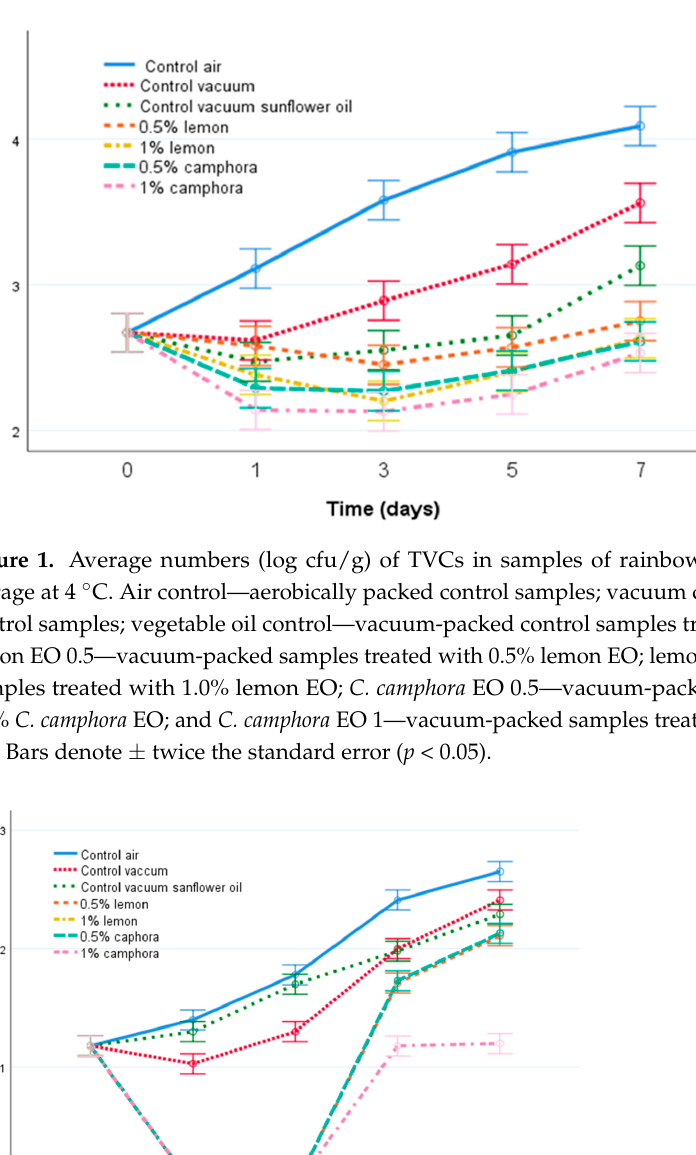
Figure 3. Evolution of counts of LAB (log cfu/g) in samples of rainbow trout during 7 days of storage at 4 °C. Air control—aerobically packed control samples; vacuum control—vacuum ‐ packed control samples; vegetable oil control—vacuum ‐ packed control samples treated with sunflower oil; lemon EO 0.5—vacuum ‐ packed samples treated with 0.5% lemon EO; lemon EO 1—vacuum ‐ packed samples treated with 1.0% lemon EO; C. camphora EO 0.5—vacuum ‐ packed samples treated with